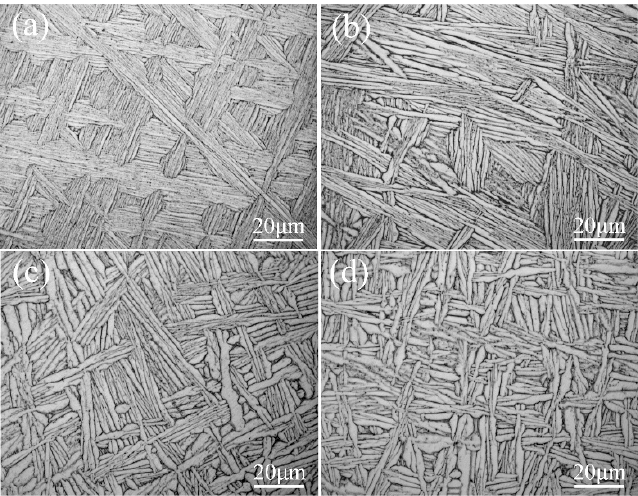
Figure 4. The optical micrographs of Ti6Al4V- x Er casting alloys: ( a ) x = 0; ( b ) x = 0.2; ( c ) x = 0.4; ( d ) x = 0.6 wt %.